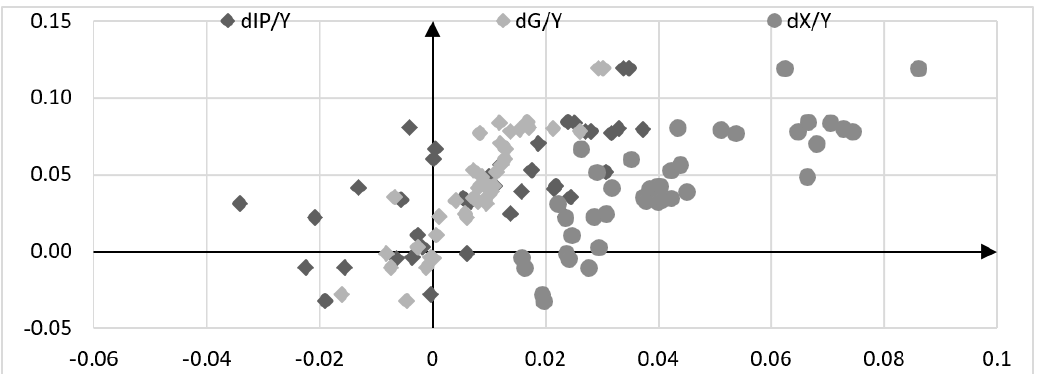
Figure 14. Correlation of changes in autonomous expenditure to changes in gross value added— Germany, own work, source: Eurostat.